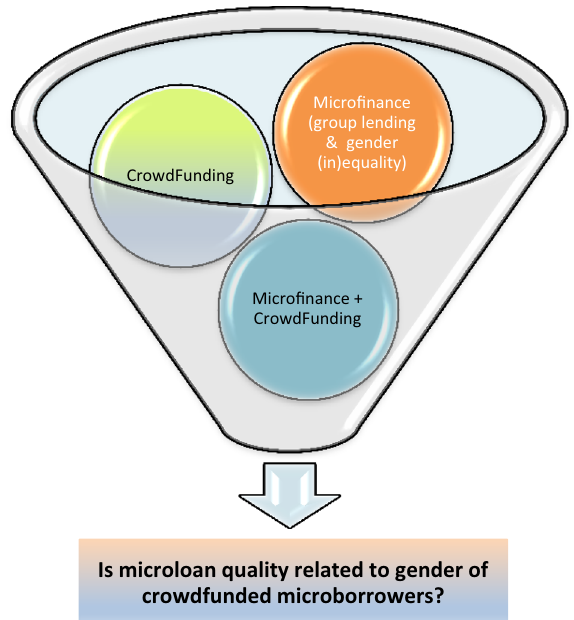
Fig. 4 From the literature strands to the research question. It schematizes that the crowdfunded microloan analyzed in this paper is a hybrid product of a microloan and a crowdfunded loan. Source: Own